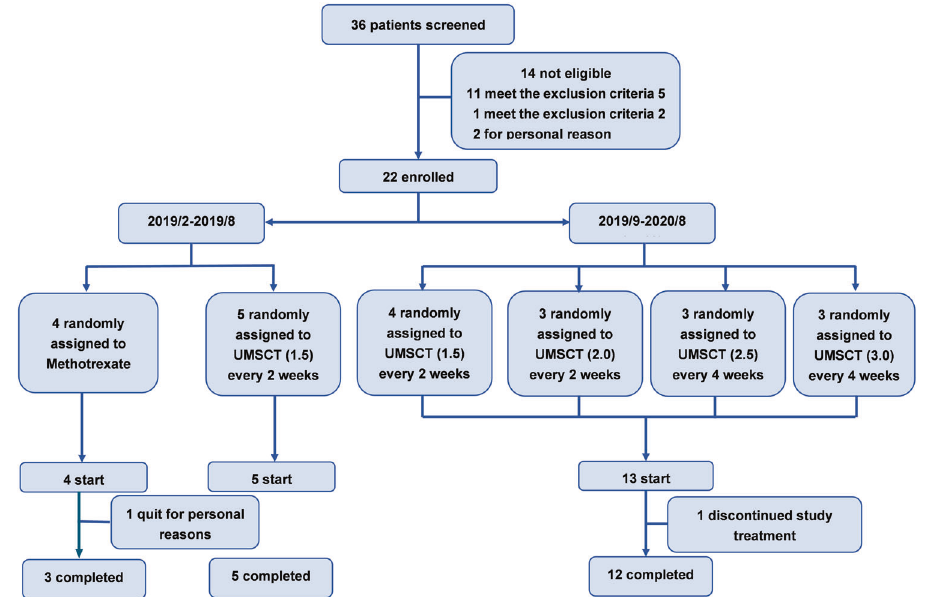
Fig. 1 Flowchart of the study